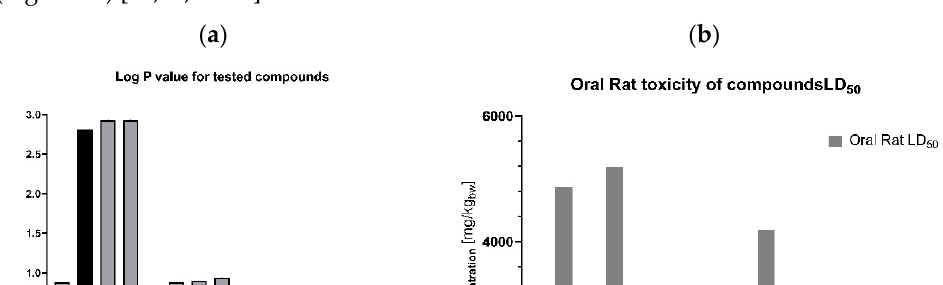
Figure 12. ADME analysis. CYP inhibitor prediction of fluconazole 1 , lactones 2–4 , analogues of fluconazoles 5–15 based on their chemical structure. Only 8 of them show inhibition of CYPs. 2.2.1. Phthalide Lactones 2–4 The obtained phthalide lactones 2–4 (Figure 2), i.e., internal esters, have a similar structure and differ in the number and position of double bonds. 3- n -Butylphthalide ( 2 ) and 3- n -butylidenephthalide ( 3 ) are aromatic compounds and therefore have a flat struc- ture. 3-Butyl-4,5,6,7-tetrahydrophtalide ( 4 ) has only one double bond, and the cyclohex- ene ring is not flat; its conformation may change depending on the environment. Lactones 2–4 have a molecular weight of 188–194 g/mol. Fluconazole has a different chemical struc- ture. The consequence of different chemical structure is different lipophilicity. Flucona- zole dissolves better in water than fats and lactones 2–4 and vice versa Lactones 2–4 and fluconazole differ in their toxicity (Figure 11b). Fluconazole is 3 to 10 times more toxic than the lactones shown. The difference in toxicity between the individual lactones is sur- prising. Fluconazole is a potent inhibitor of CYP2C19, responsible in mammal’s liver for detoxifying up to 20% of drugs (2 3]. 3- n -butylphthalide inhibits CYP1A2 and three times more toxic 3-butylidenephthalide than CYP2C9. The least poisonous 3- n -butyl-4,5,6,7-tet- rahydrophtalide ( 4 ) is not a potent inhibitor of CYP.